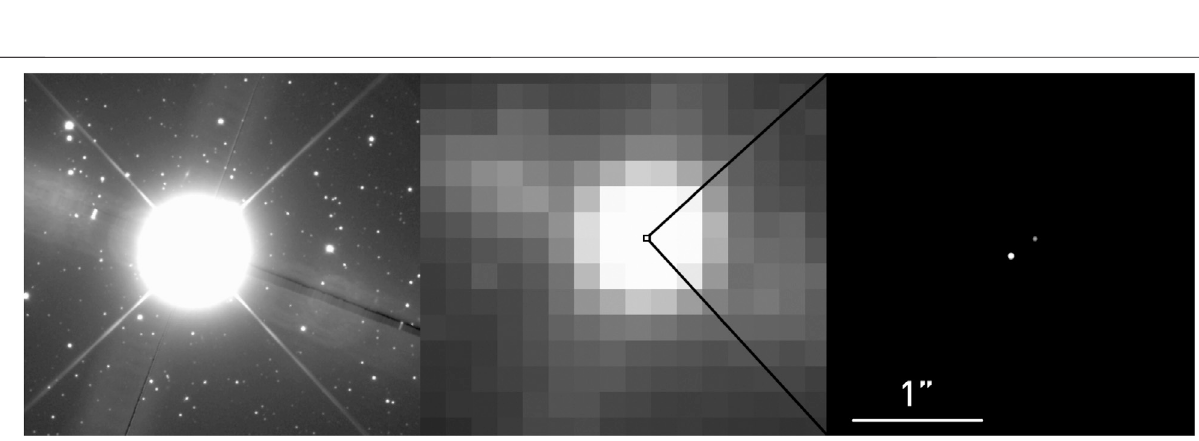
Frontiers in Astronomy and Space Sciences |